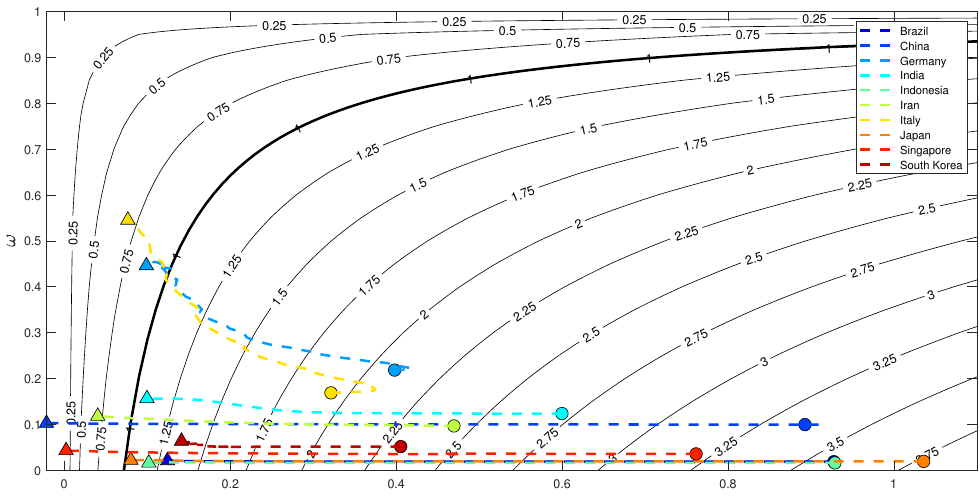
Figure 15. Evolution of the reproduction number in the 60-day simulation of the second transmission. The solid black lines are the level sets of R 0 taken from (27) for constant ω and a . The evolution starts from circle-shaped graphs and ends with triangular-shaped